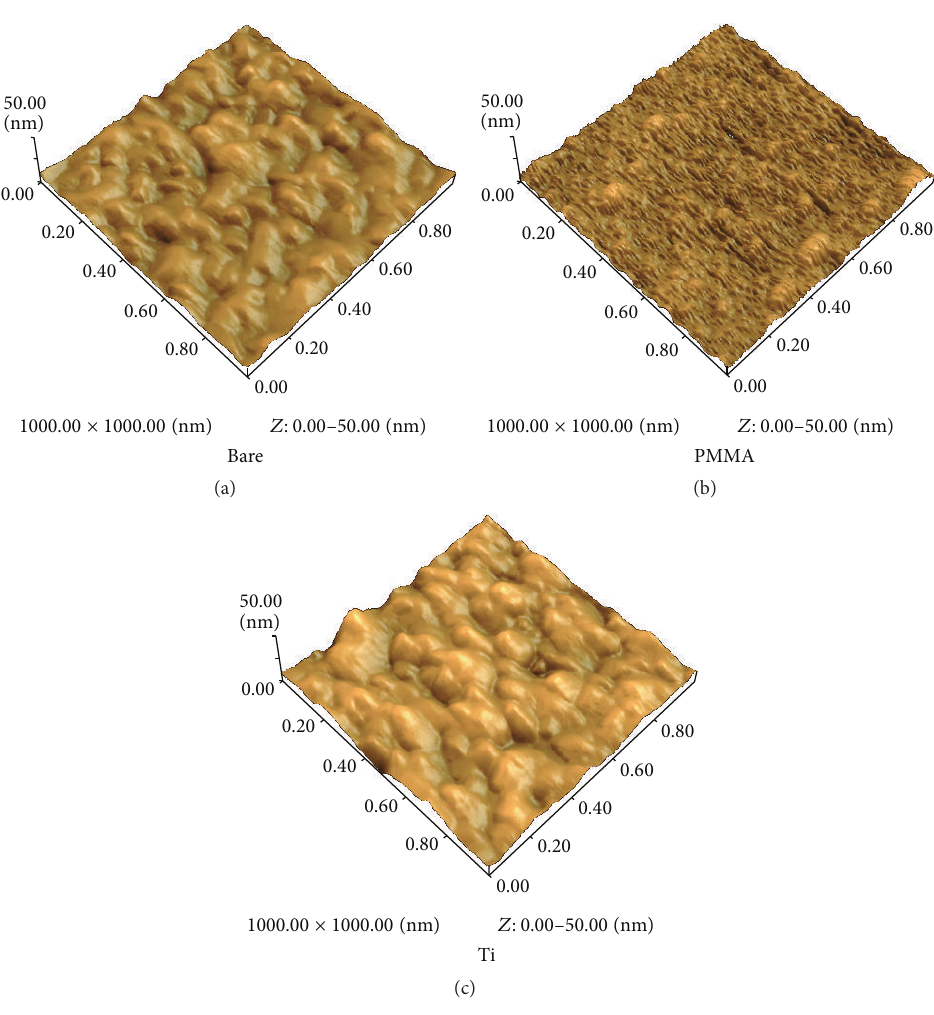
Figure 2: Scanning probe microscopy (SPM) images of bare QCM sensor (a), PMMA QCM sensor (b), and Ti QCM sensor (c).